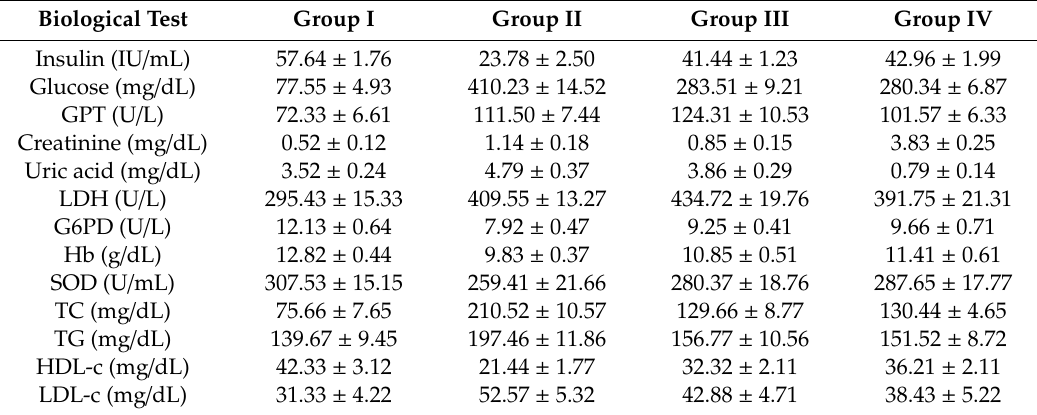
Table 3. Biochemical e ff ects of the oxidovanadium(IV)–AMP complex in vivo. SOD, superoxide dismutase; TC, total cholesterol; TG, triglyceride; HDL-c, high-density lipoprotein cholesterol; LDL-c, low-density lipoprotein